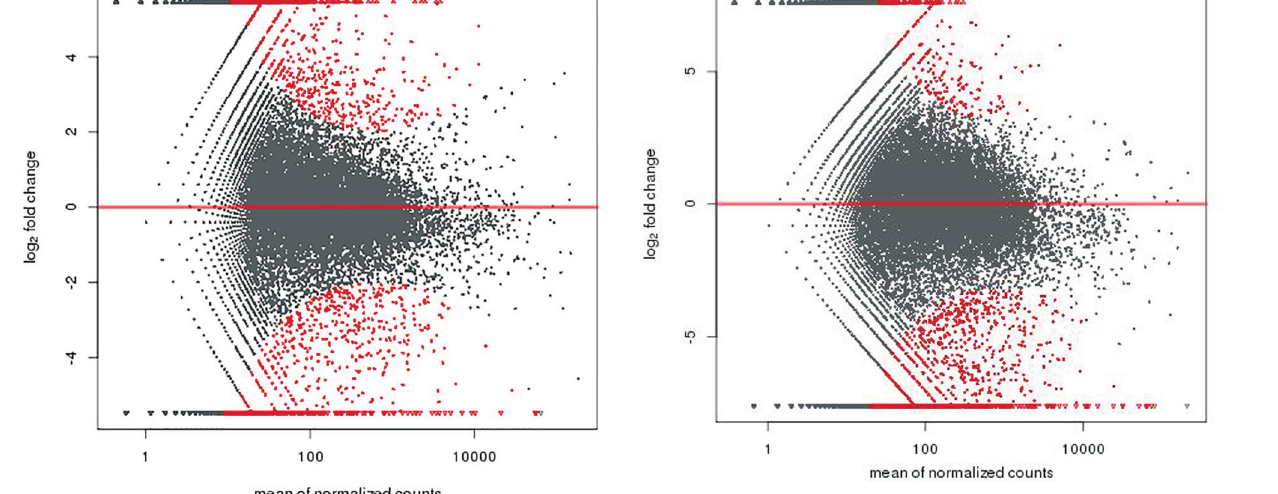
Figure 4 - A total of 1,325 genes were differentially expressed between the co-blocking group and control group, among which 273 genes were up-regulated and 1,052 down-regulated. Abscissa: mean of normalized counts; Ordinate: log 2 fold change.